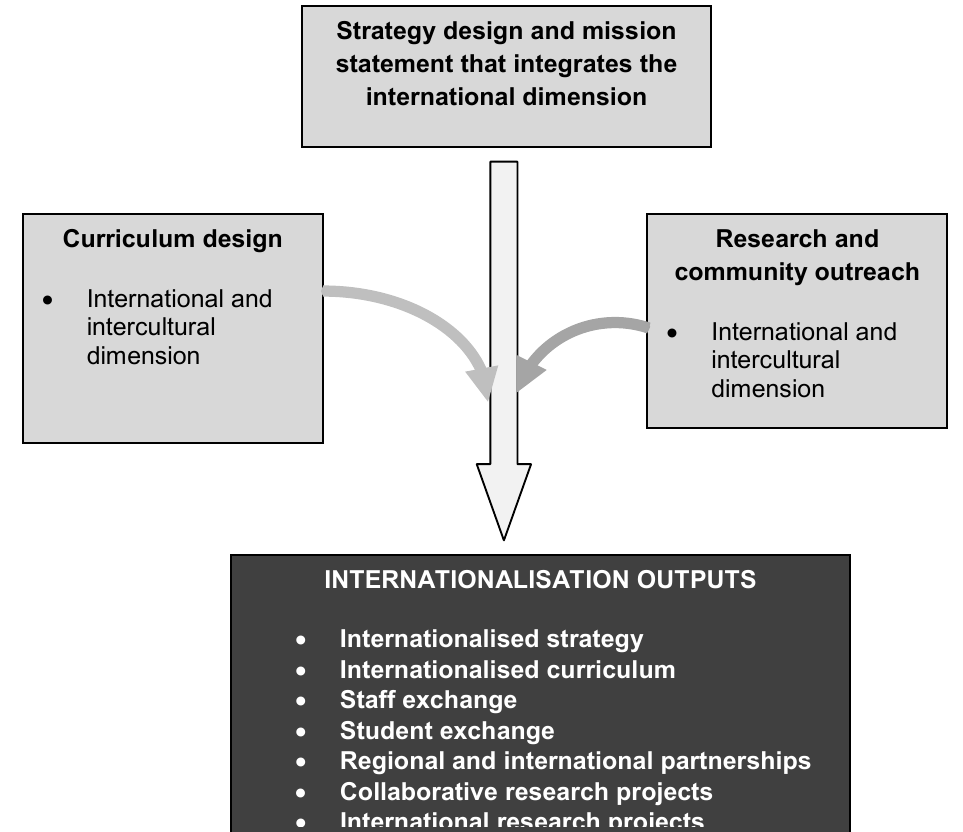
Figure 3 . Internationalisation: activities and